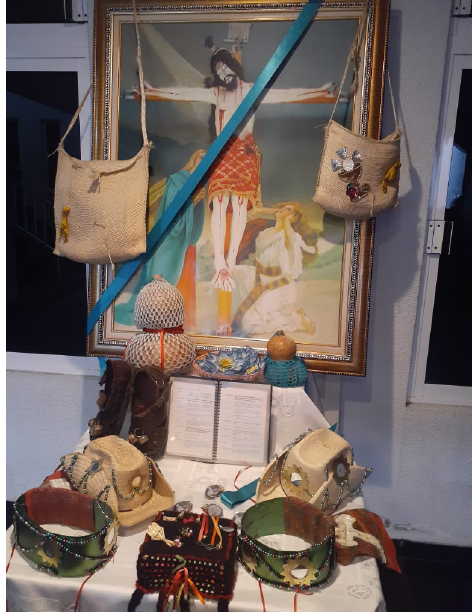
Figure 6 Special home altar with dance paraphernalia during the celebration of our Lord of Graces, 2020, Tepexpan, Estado de México. Copyright: Andrés Jaime